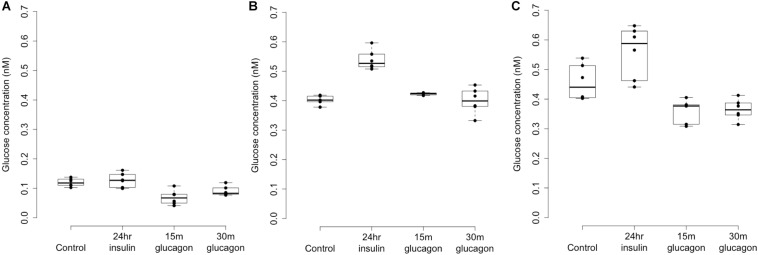
Glycogen deposition response after insulin re-stimulation of primary human hepatocytes. Panel (A) shows a donor with rs4841132 G/G genotype and Panels (B,C) show replicates of a donor with rs4841132 A/G genotype. Brief (15 or 30 min) treatment with 5 nM glucagon demonstrates a decrease in glycogen compared to the control, confirming that what is being measured is glycogen.